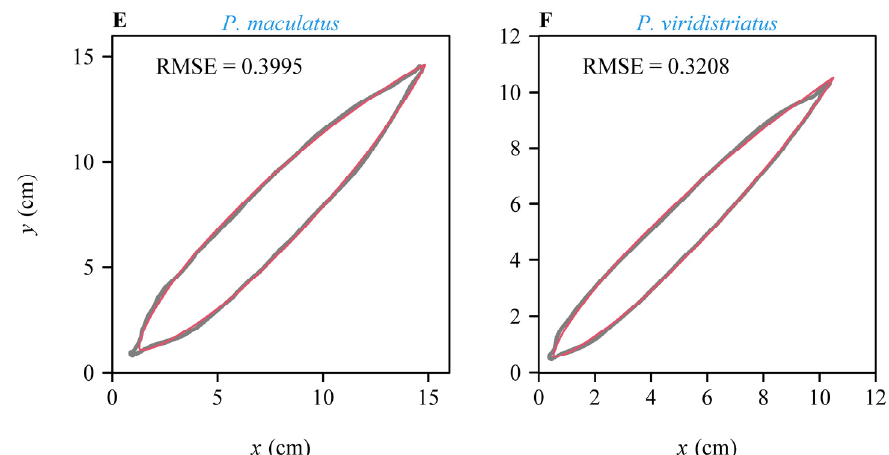
Figure 3. Illustration of the results of fitting the boundary coordinates of representative leaf samples for the six studied bamboo species (the same leaves as shown in Figure 1) using SGE-2. The gray curves are the actual scanned leaf boundaries; the red curves are the leaf boundaries predicted by the model SGE-2, i.e., Equation (4).